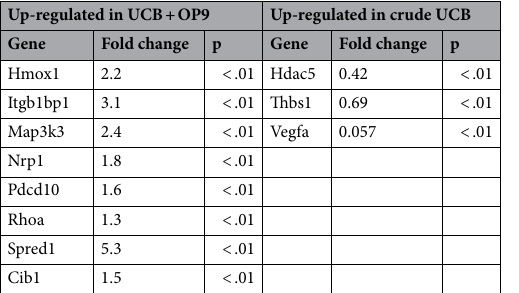
Table 1. Gene expression profiles associated with angiogenesis regulation in the monocytic